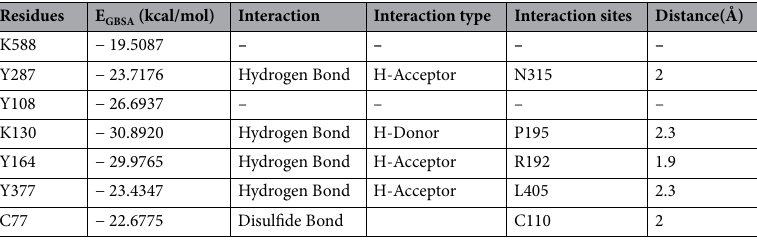
Table 10. The interaction among labeled residues and Vs.